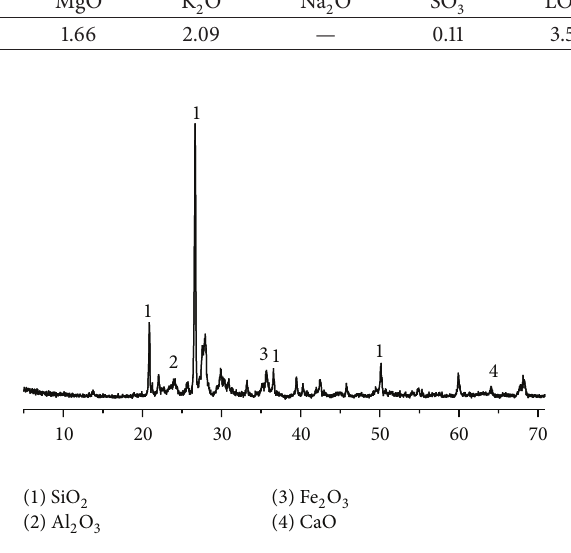
Figure 1: XRD result of